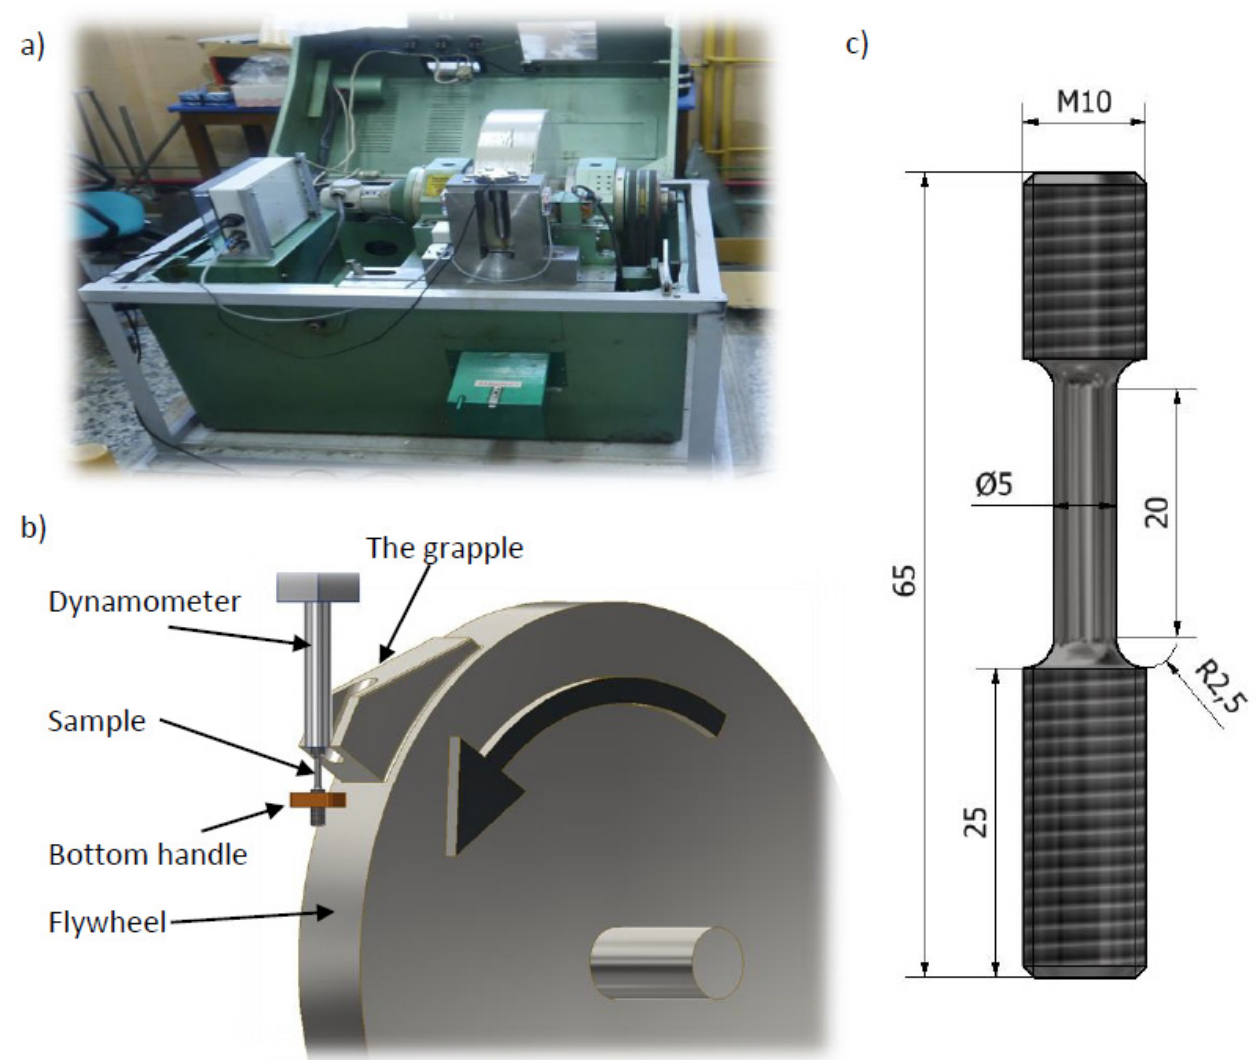
Figure 5. ( a ) Rotary hammer station (Fundamentals of Technology Laboratory, Polish Naval Academy), ( b ) scheme of dynamic tensile test on a rotary hammer, and ( c ) dimensions of a sample. Table 1. Summary of test results on a rotary